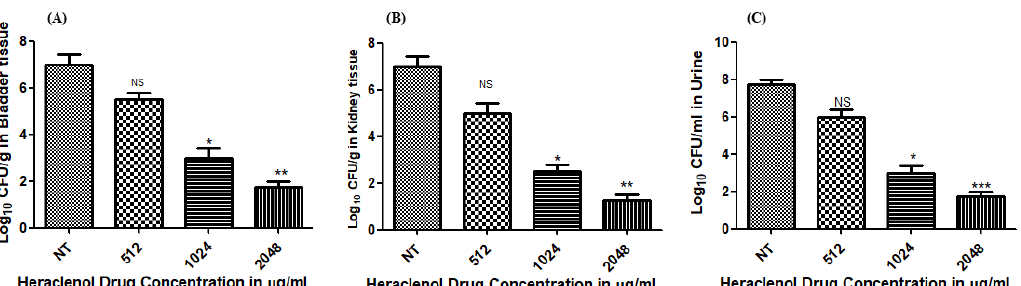
Figure 2. Effect of heraclenol on Vero cell lines. Heraclenol did not show any significant cytotoxicity as the morphology of the Vero cell line remained similar to the control cell line.